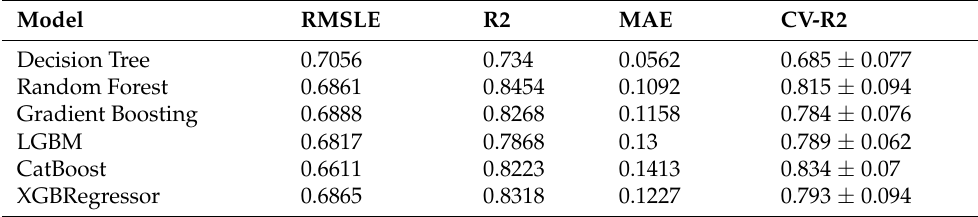
Table 9. Results of severity for the right elbow.